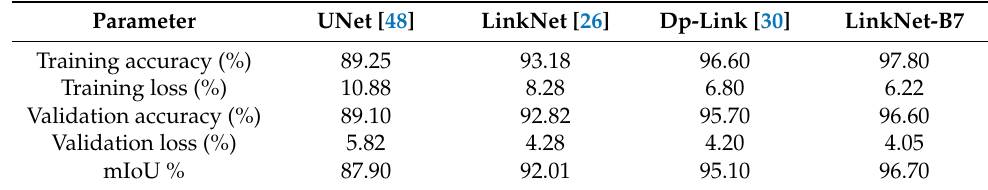
Table 4. The results obtained with different models in the lesion segmentation phase.